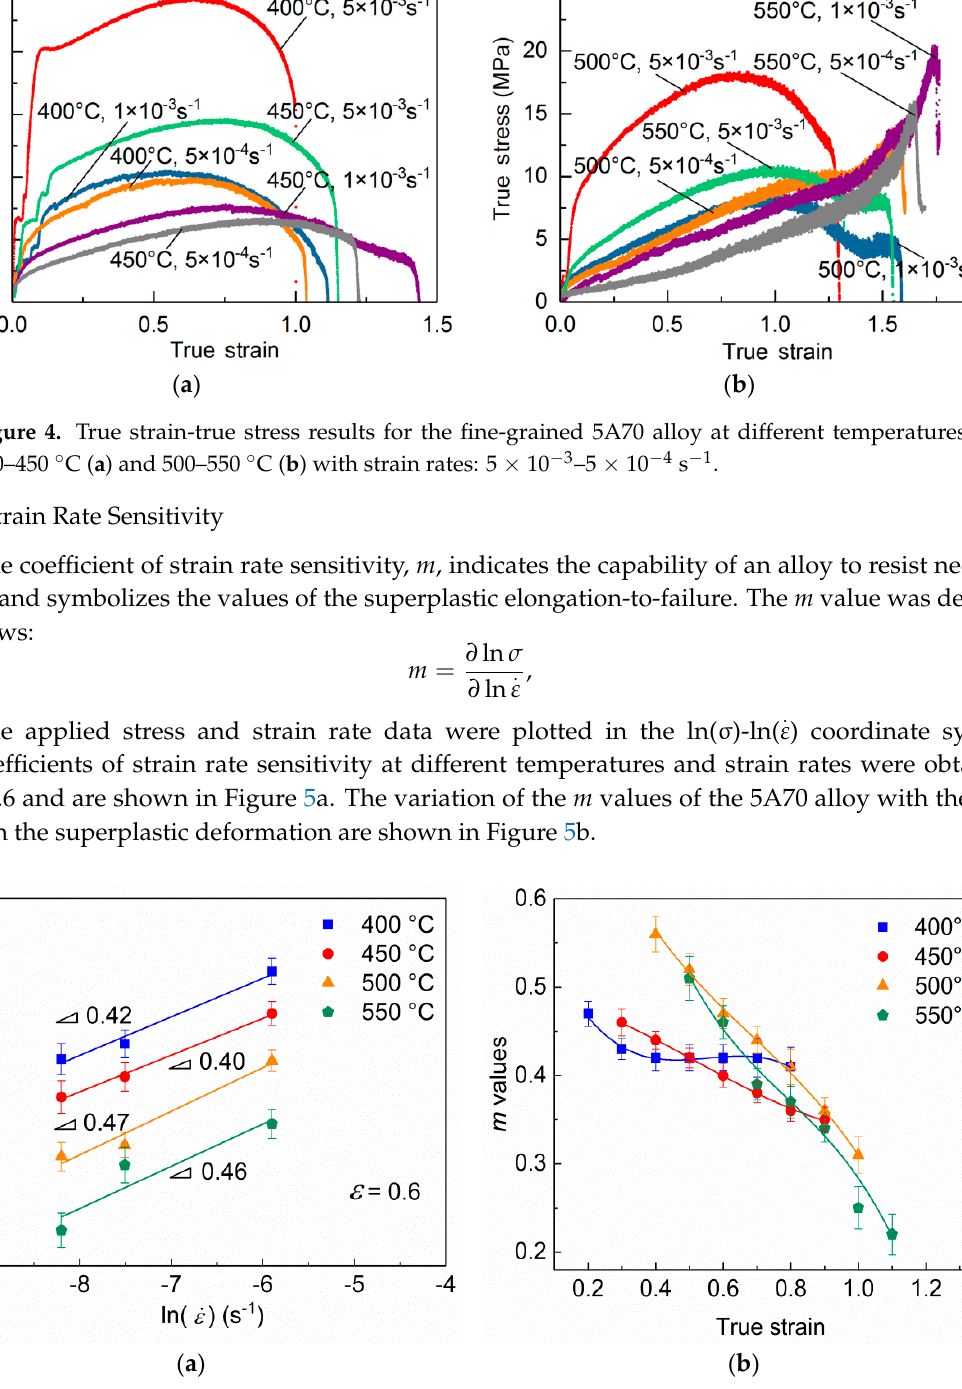
Figure 5. Coefficients of the strain rate sensitivity, m , at ε = 0.6 ( a ) and the m values during superplastic deformation at 400–550 °C ( b ).